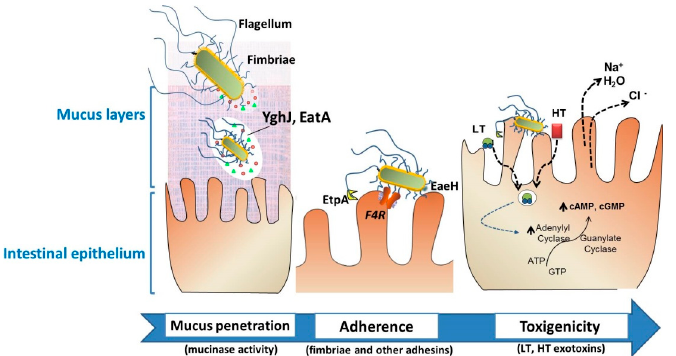
Figure 2. Intestinal colonization through the action of particular virulence factors of enterotoxigenic Escherichia coli (ETEC). Neonatal and post-weaning pig diarrheas are mostly associated with